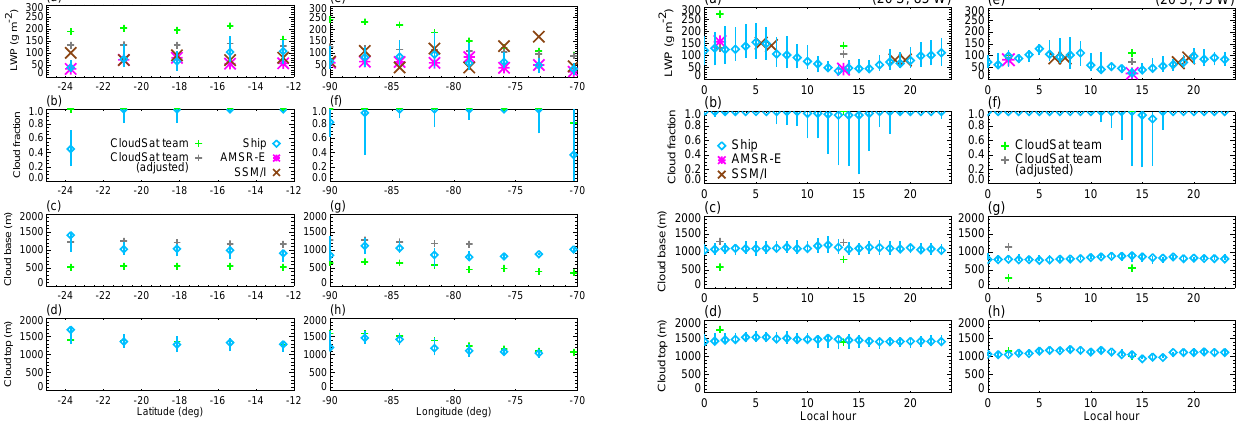
Fig. 4. Median hourly (a, e) LWP, (b, f) cloud fraction, (c, g) Figure 4. Median hourly (a,e) LWP, (b,f) cloud fraction, (c,g) cloud base, and (d,h) cloud top cloud base, and (d, h) cloud top at (20 ◦ N, 85 ◦ W) (a–d) and at at (20°N, 85°W) (a-d) and at (20°N, 75°W) (e-h) from the 2001-2007 Stratus cruises (with the (20 ◦ N, 75 ◦ W) (e–h) from the 2001–2007 Stratus cruises (with the interquartile ranges indicated by the vertical lines); and the CloudSat team products with interquartile ranges indicated by the vertical lines); and the Cloud- LWPs adjusted to remove suspected precipitation contamination and based upon adiabatic Sat team products with LWPs adjusted to remove suspected precip- cloud bases derived from thicknesses from Eq. (1) also shown; AMSR-E and SSM/I for LWP itation contamination and based upon adiabatic cloud bases derived only. from thicknesses from Eq. (1) also shown; and AMSR-E and SSM/I for LWP